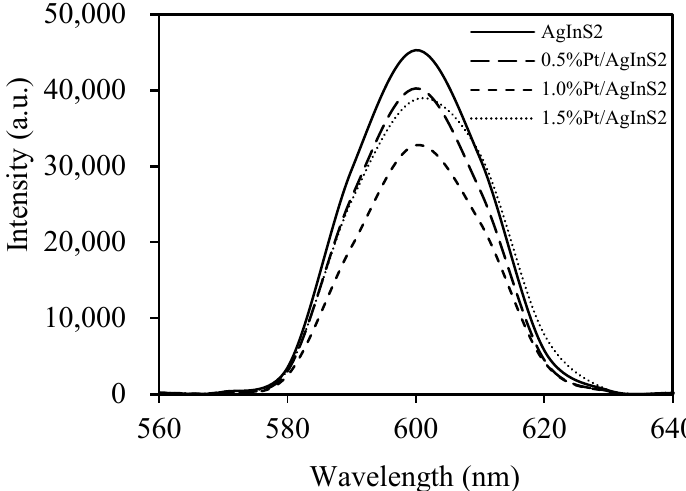
Figure 5. Photoluminescence (PL) emission spectra of AgInS 2 and Pt/AgInS 2 photocatalysts.